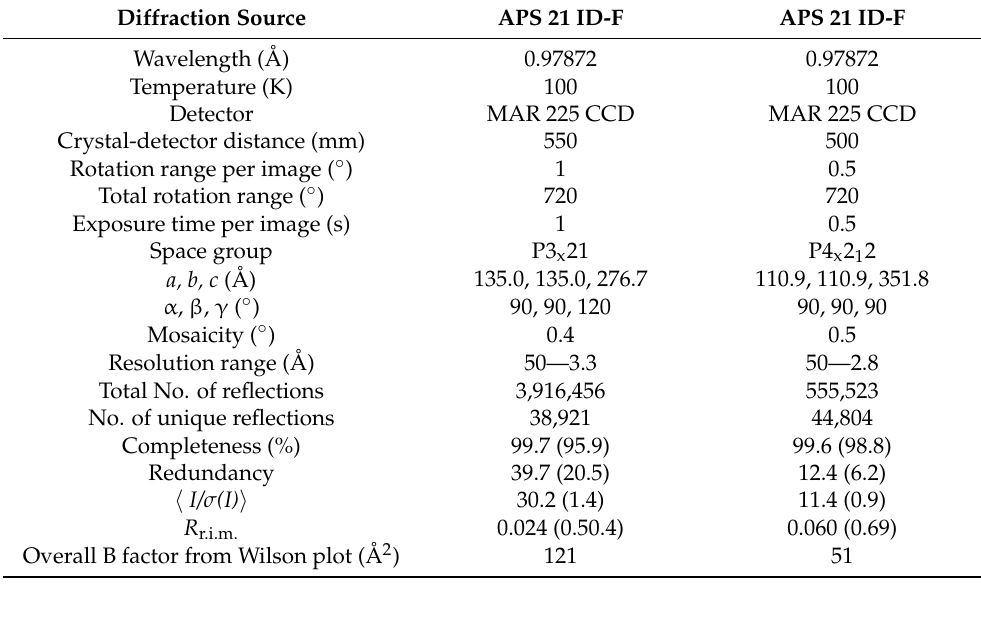
Table 2. X-ray diffraction data collection and processing. Values for the outer shell are given in parentheses.